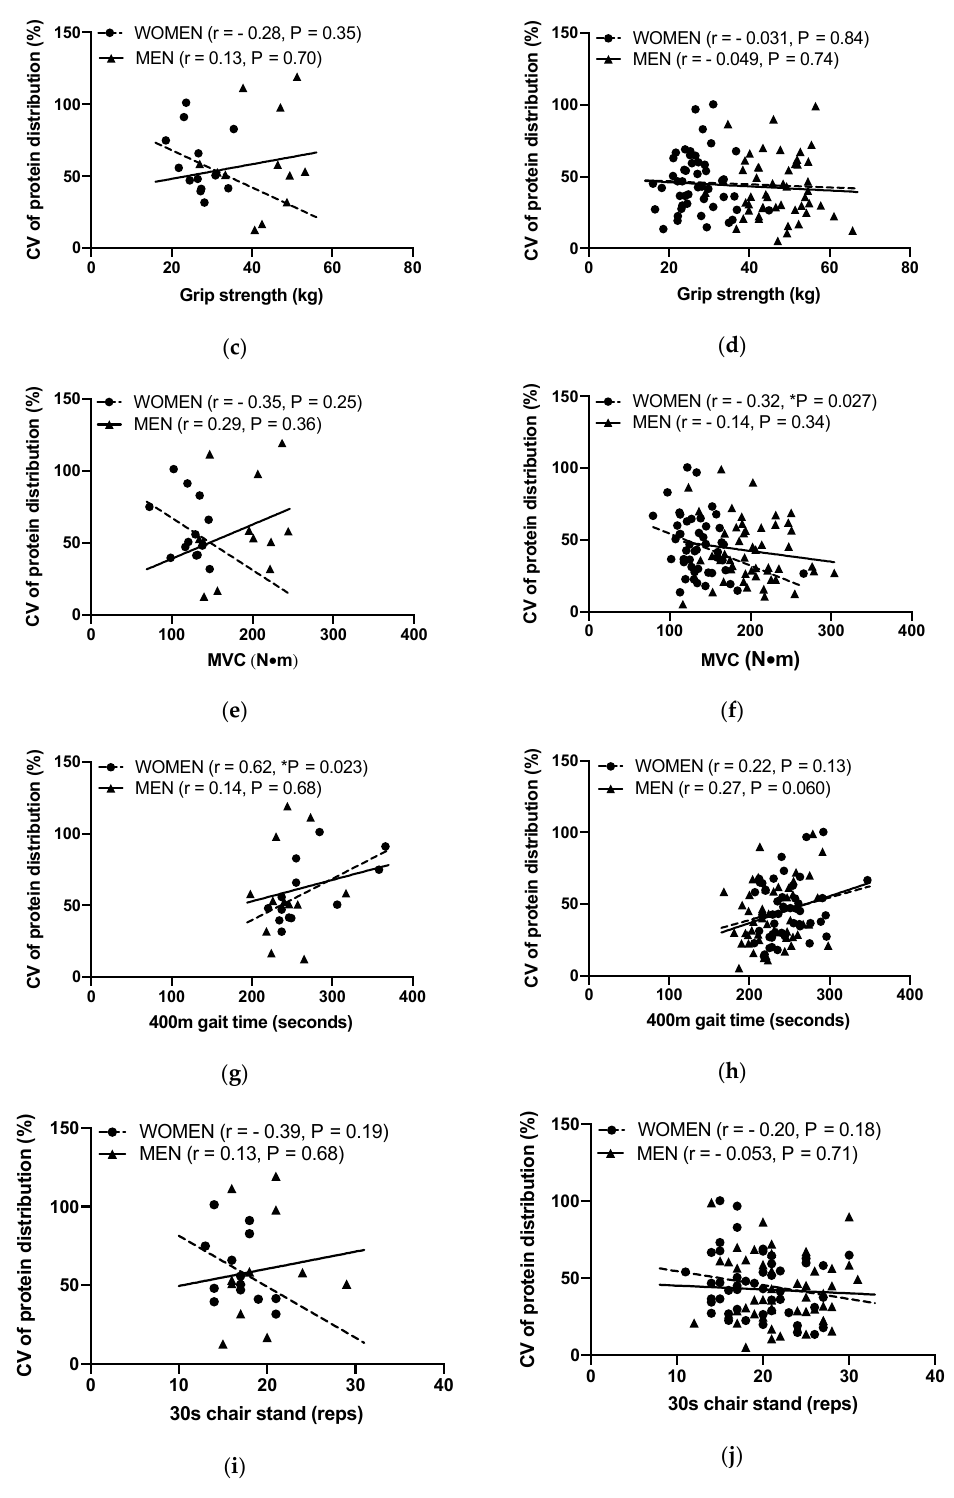
Figure 3. The association between the protein distribution for participants with a lower protein intake ( n = 25, 12 men and 13 women) and a higher protein intake ( n = 98, 50 men and 48 women ( n = 47 for Maximal Voluntary isometric Contraction (MVC) due to one missing value)) and Appendicular Skeletal Muscle Index (ASMI) (( a ) / Lower, ( b ) / Higher), grip strength (( c ) / Lower, ( d ) / Higher), knee extension MVC (( e ) / Lower, ( f ) / Higher), 400 m gait time (( g ) / Lower, ( h ) / Higher), and 30 s chair stand (( i ) / Lower, ( j ) / Higher). * p < 0.05, Pearson’s correlation coe ffi cient was used to identify the associations. Significance was set at p <